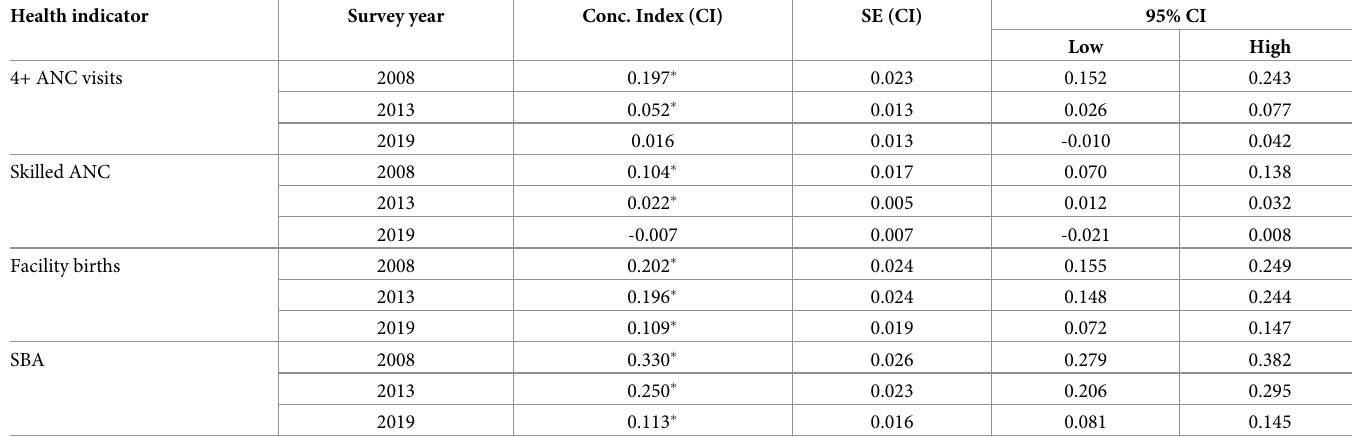
Table 5. Concentration indices showing wealth-based inequality in the use of maternal health services in Sierra Leone, 2008, 2013 and 2019. Health indicator